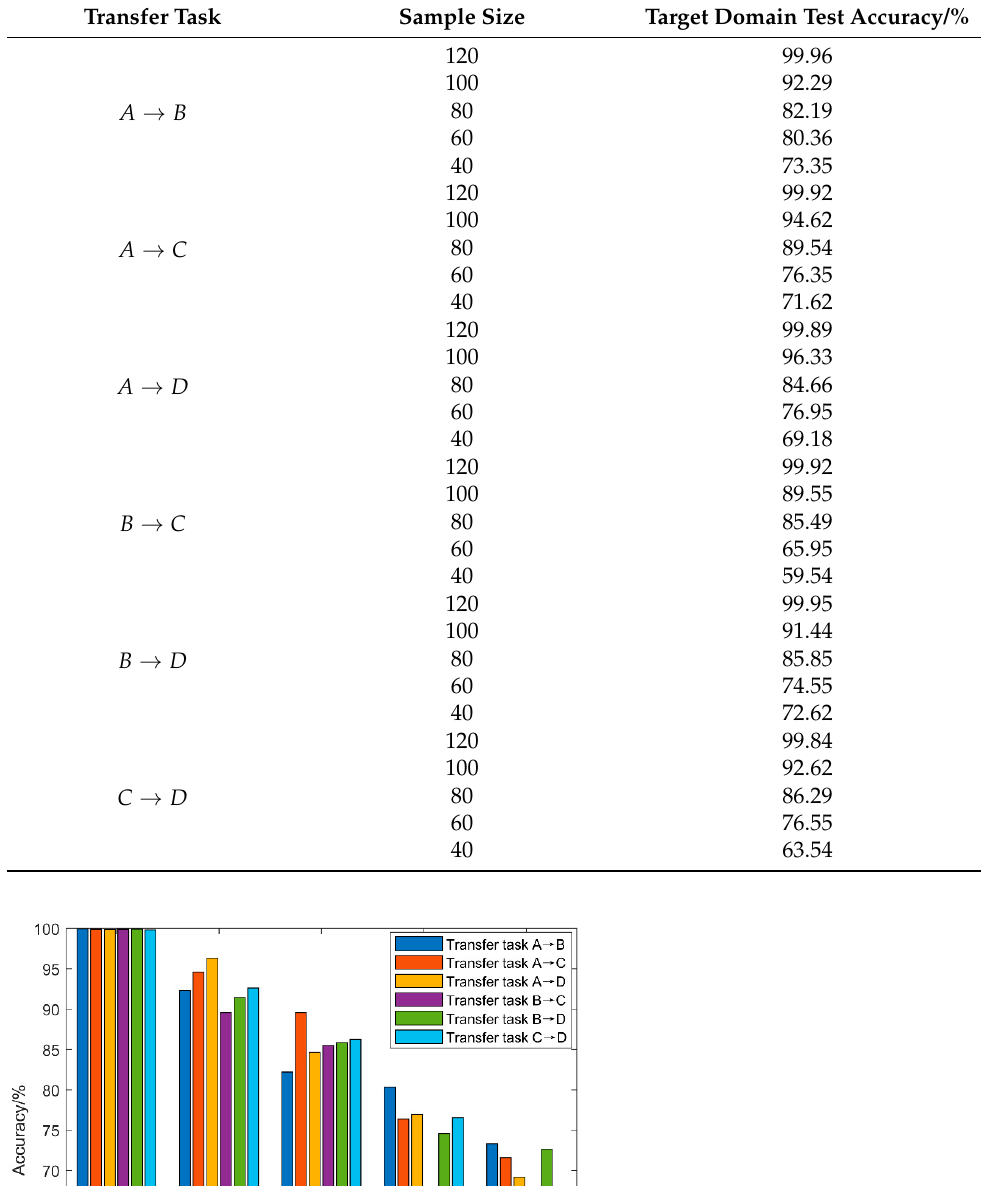
Table 8. Diagnostic performance of the algorithm with different sample sizes.